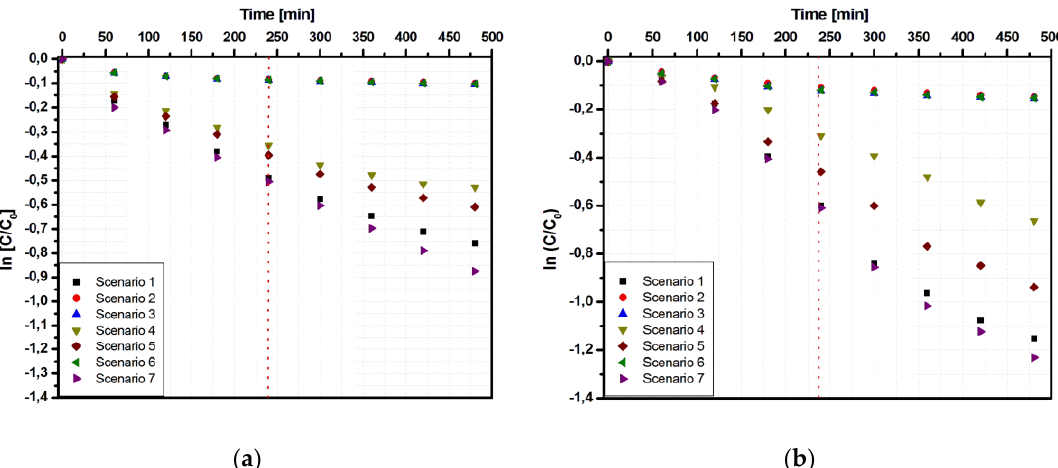
Figure 7. Kinetic data of the Ti_FTO sample using the Langmuir–Hinshelwood correlation: ( a ) Tr and ( b ) Apd photodegradation.